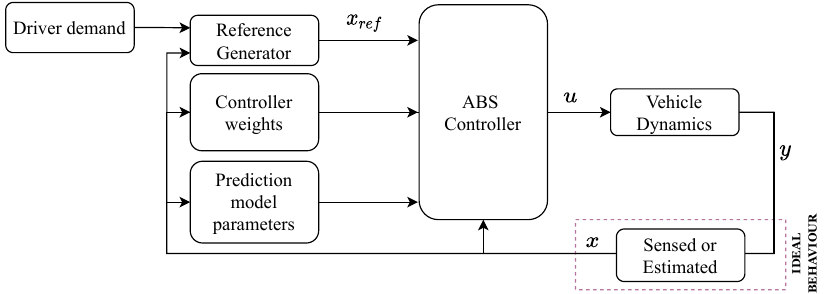
Figure 16. Full-car simulation’s general